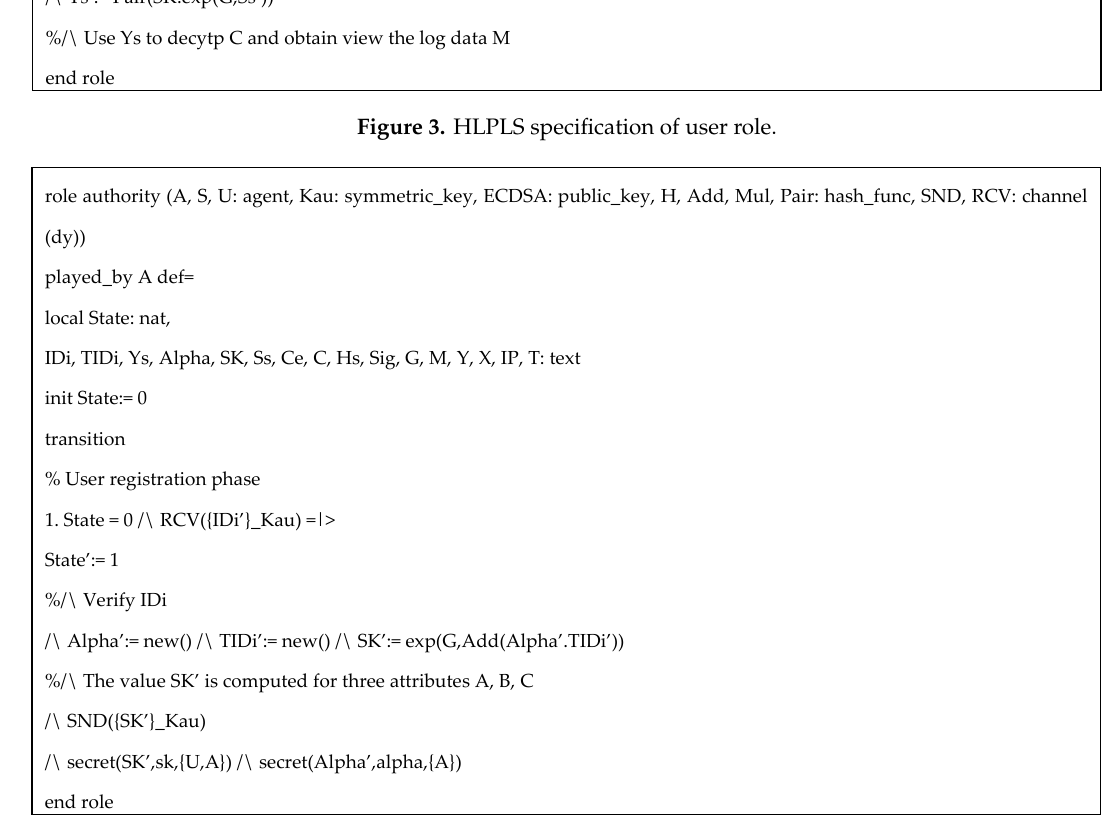
Figure 4. HLPLS specification of attribute authority role.